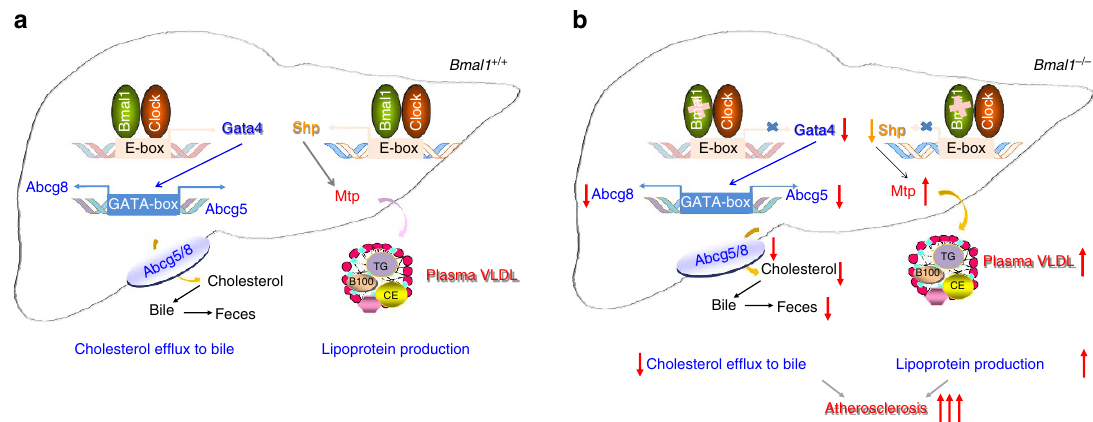
Figure 10 | Role of hepatic Bmal1 in plasma and hepatic lipid metabolism. ( a ) Our data show that Bmal1 may regulate Gata4 and Shp to modulate two different hepatic functions. Bmal1/Clock heterodimer interacts with the E-boxes in the Gata4 and Shp promoter to enhance their expression. Increased expression of Gata4 results in enhanced binding to the GATA-box present in the Abcg5/Abcg8 promoter resulting in increased transcription. This may contribute to increased excretion of cholesterol to bile and feces. On the other hand, increased expression of Shp represses MTP expression leading to reduced lipoprotein production. ( b ) Bmal1 deficiency reduces Gata4, Abcg5 and Abcg8 expression leading to reduced cholesterol excretion into the bile. Gata4 deficiency may also reduce Shp expression and increase MTP expression and VLDL production. Increases in VLDL secretion and reductions in cholesterol excretion to the bile may additively contribute to